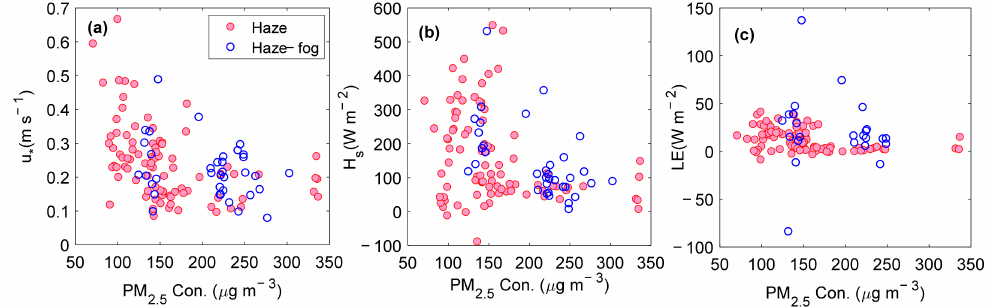
Figure 10. Relationship of hourly mean PM 2.5 concentration to ( a ) friction velocity, ( b ) sensible heat flux, and ( c ) latent heat flux during haze and haze–fog mixed episodes in